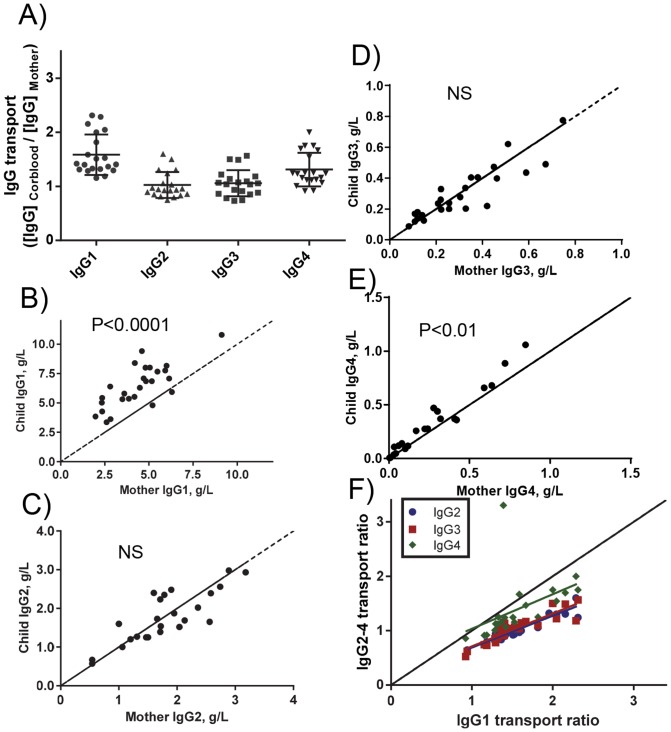
Placental transport of IgG subclasses is more efficient for IgG1 and IgG4 than for IgG2 and IgG3.Blood was collected from mothers just before or after birth and from neonates birth. A) Transport rates for all IgG subclasses expressed as cord/maternal ratios found at birth. The transport rates differed significantly from each other (P<0.0001), except for IgG2 and IgG3 (not significant), as tested by one-way Anova and Tukey's multiple comparison test. (B–E)IgG subclass 1–4 serum levels were quantified by nephelometry and each pair was plotted on a X axis displaying days of each pregnancy against IgG concentration. Average neonate concentration was significantly higher than in the mother for IgG1 and IgG4 as tested by a paired-T test as shown (child/mother ratio = 1.55 and 1.38, respectively) while averge concentrations for IgG2 and IgG3 were not significantly different in mothers and their children (child/mother ratios not significantly different from 1). One pre-term baby was identified displaying low transport of all IgG (square symbol). (F) Child/mother transport ratio of subclasses IgG2-4 for each pair was plotted relative to the IgG1 transport ratios.